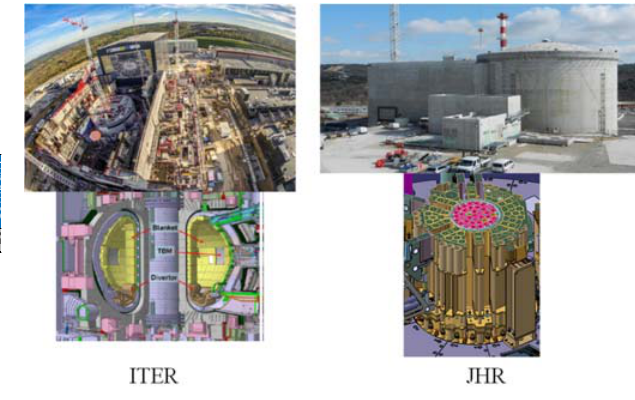
Fig. 3. Photographs of major nuclear facilities under construction in the south of